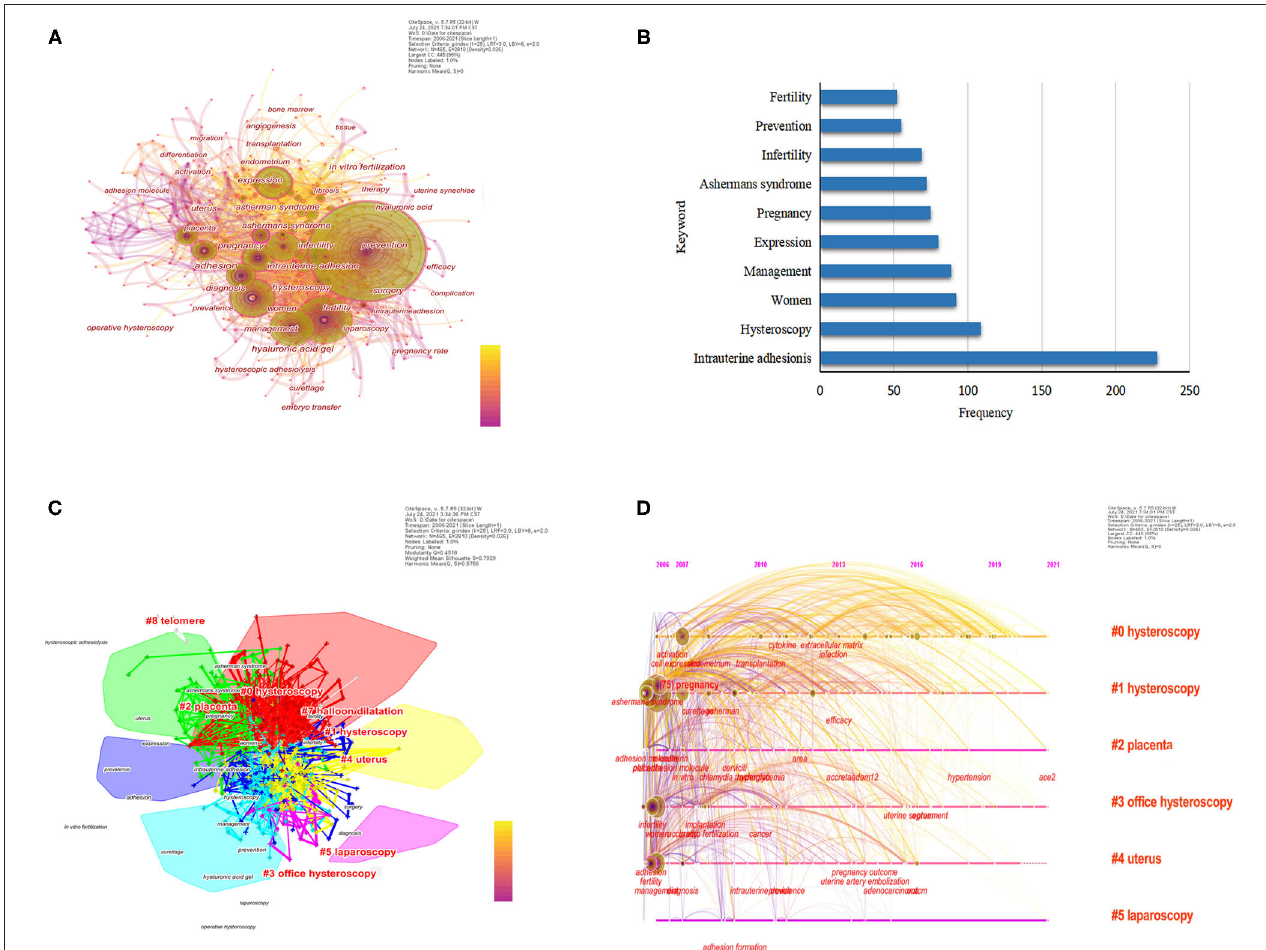
FIGURE 4 | The visual images of keywords generated by CiteSpace software. (A) The visual images of the totel of keywords. (B) Top 10 keywords with the highest frequency. (C) The visual images of cluster analysis of all keywords. (D) The timeline zone of top 8 clusters.